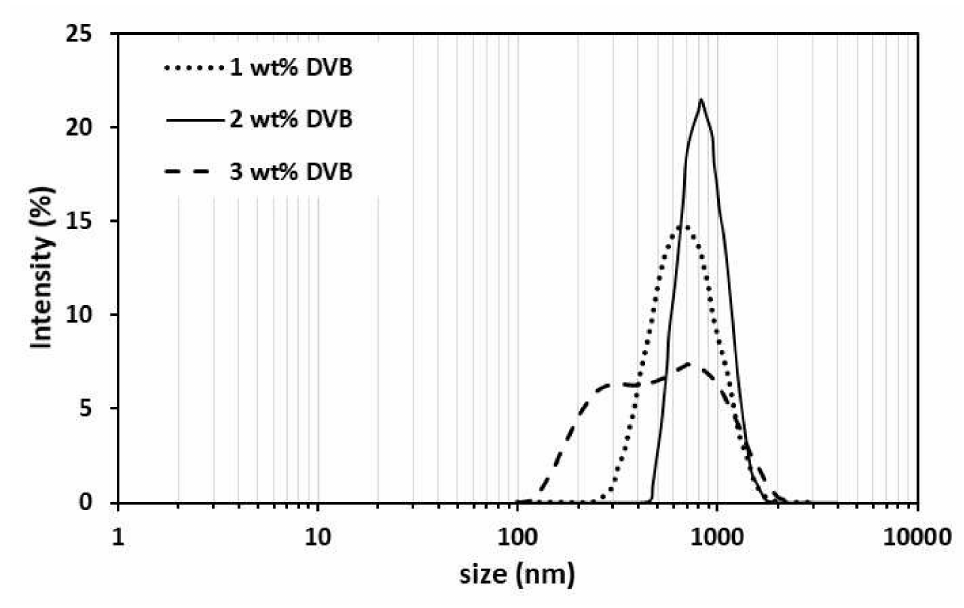
Figure 2. Microsphere size distributions prepared in Pickering emulsion polymerization at pH =